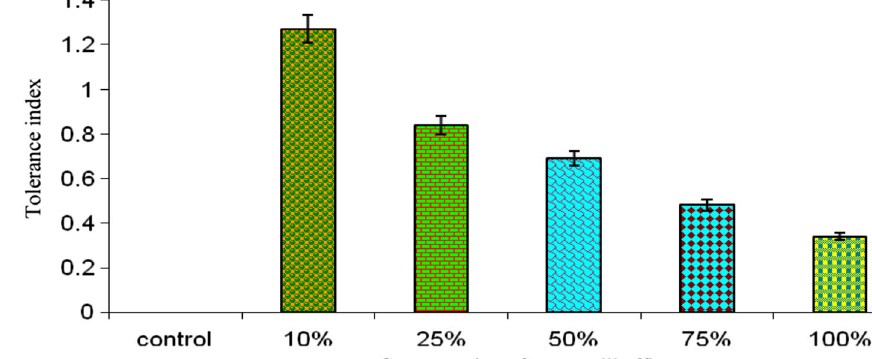
Fig. 6 Percentage of phytotoxicity of Tagetes erecta L. grown under different concentrations of sugar mill